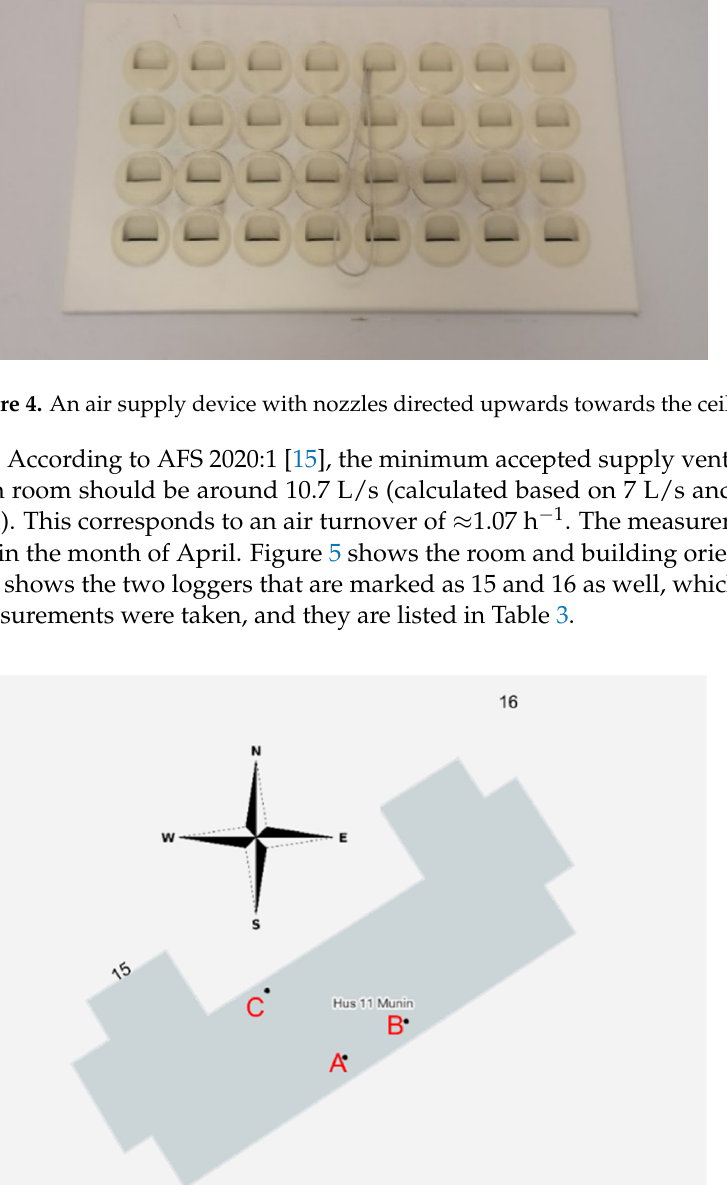
Figure 5. Overview of the building and room location and orientation. 15 and 16 indicate the location